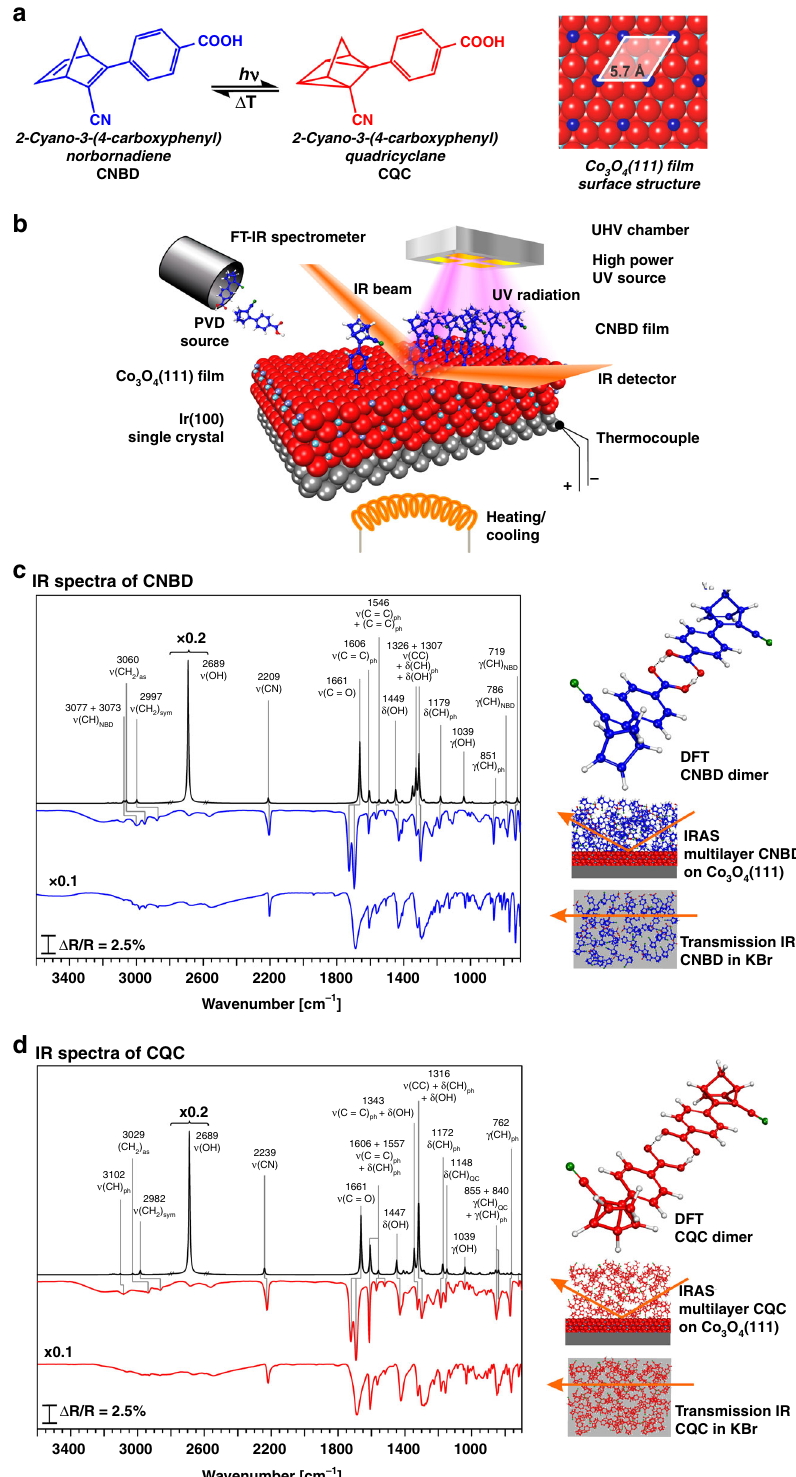
Fig. 1 The molecular photoswitch used in this study: a molecular structures of the energy-lean isomer CNBD and the energy-rich isomer CQC; b schematic representation of the in-situ photochemical IRAS setup in UHV used in this work; c IR spectra of CNBD (from top to bottom): IR spectrum calculated by DFT, IR re fl ection absorption spectrum of CNBD multilayer deposited by PVD referenced to a background of a clean sample, IR transmission spectrum of CNBD in KBr; d IR spectra of CQC (from top to bottom): IR spectrum calculated by DFT, IR re fl ection absorption spectrum of CQC multilayer deposited by PVD referenced to a background of a clean sample, IR transmission spectrum of CQC in